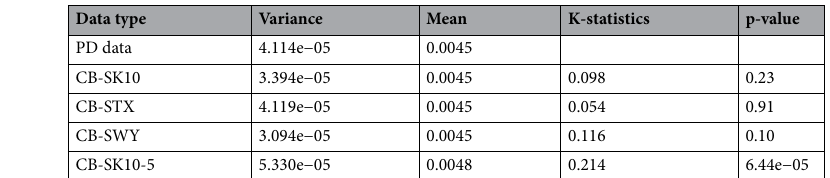
Table 1. The variance, and mean for all data, and the Kolmogorov–Smirnov statistics for the smoothed Base case distribution in comparison to the distribution of the other